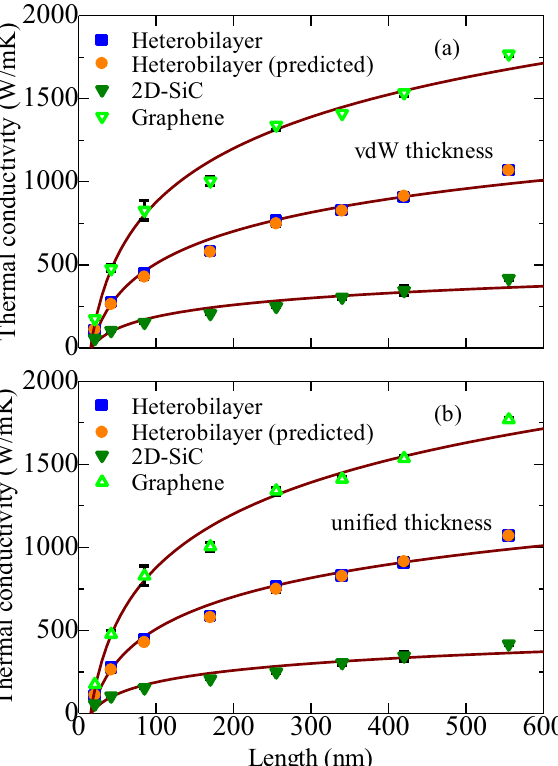
Figure 5. Length dependent in-plane thermal conductivity of graphene, 2D-SiC, and the graphene/2D-SiC heterobilayer with ( a ) vdW thickness and ( b ) unified thickness where the length varied from 22 to 555 nm with fixed-width 10.8 nm. The solid line indicates the theoretically calculated in-plane thermal conductivity of the heterobilayer from Eq. (7) which corresponds well with the RNEMD calculation. Three independent simulations with different initial conditions are used to suppress the statistical